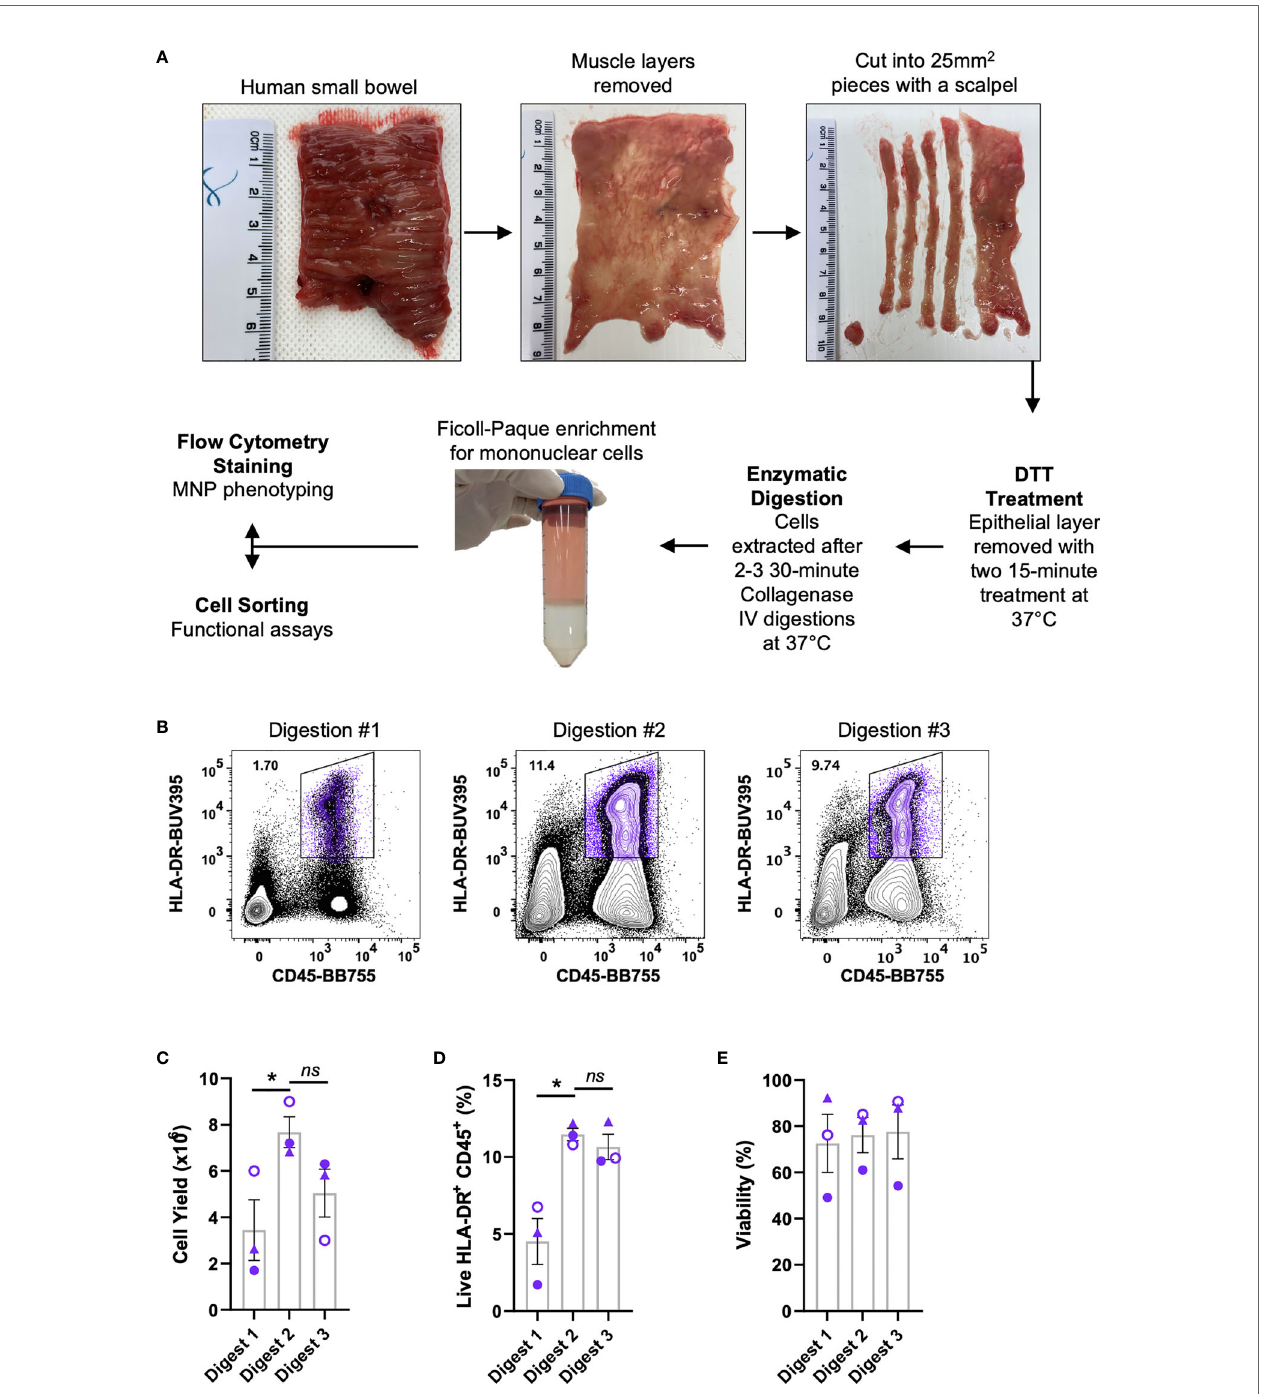
FIGURE 1 | Isolation of immune cells from human intestinal tissues. Discarded human intestinal tissues were obtained within one hour of surgery. (A) Underlying tissue was removed using curved surgical scissors before being diced into small pieces with a scalpel. Tissue was treated with DTT for two 15 min incubations at 37°C prior to 2-3 30 min digestions with collagenase type IV. Mononuclear cells were enriched using a Ficoll-Paque gradient before cells were stained for phenotyping or cell sorting. (B) Representative plot of live HLA-DR + CD45 + proportions from each digestion. (C) Cell yields from each digestion, counted post-Ficoll on a haemocytometer. (D) Percentage of live HLA-DR + CD45 + cells from total cells as determined by fl ow cytometry. (E) Percentage of viability of each digestion as determined by fl ow cytometry with mean ± SEM. Each symbol represents an individual donor (n=3). Statistics was by a Kruskal Wallis test with Dunn ’ s multiple comparisons test comparing the sequential digests (*p < 0.05, ns, not signi fi